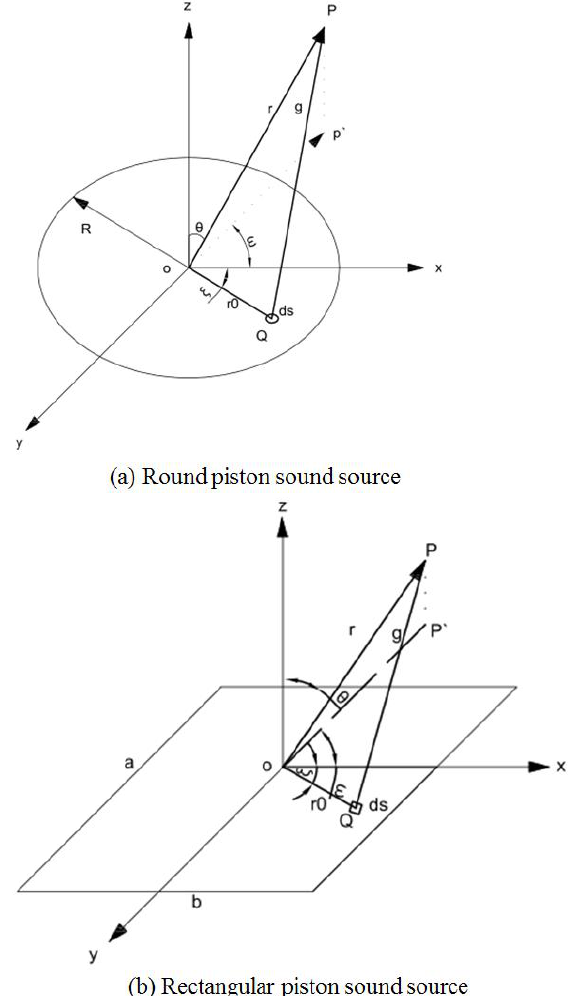
Figure 10. Distribution of radiated sound field. ( a ) round piston sound source, ( b ) rectangular piston sound source.